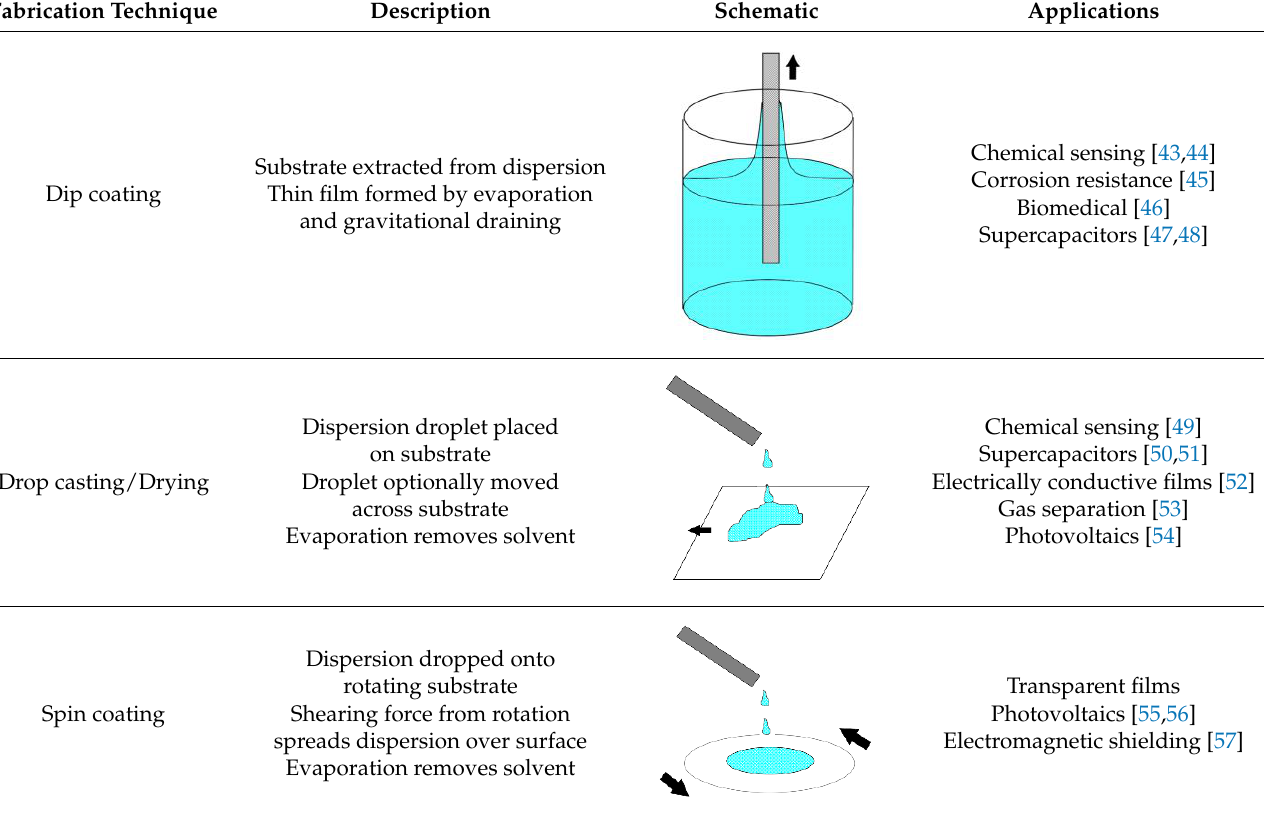
Droplet optionally moved across